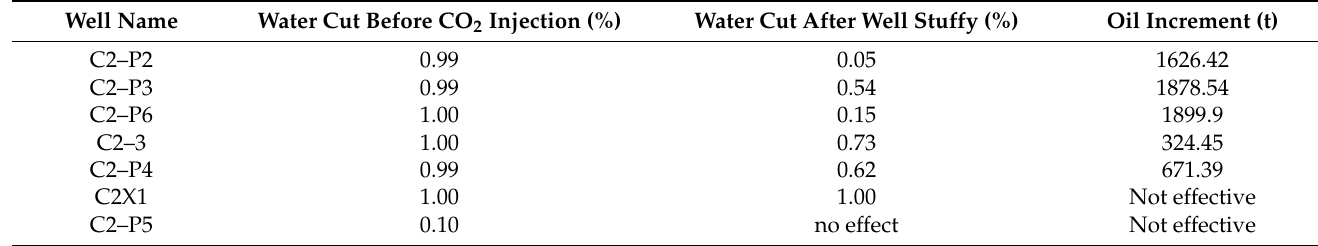
Table 11. Parameter statistics before and after CO 2 huff and